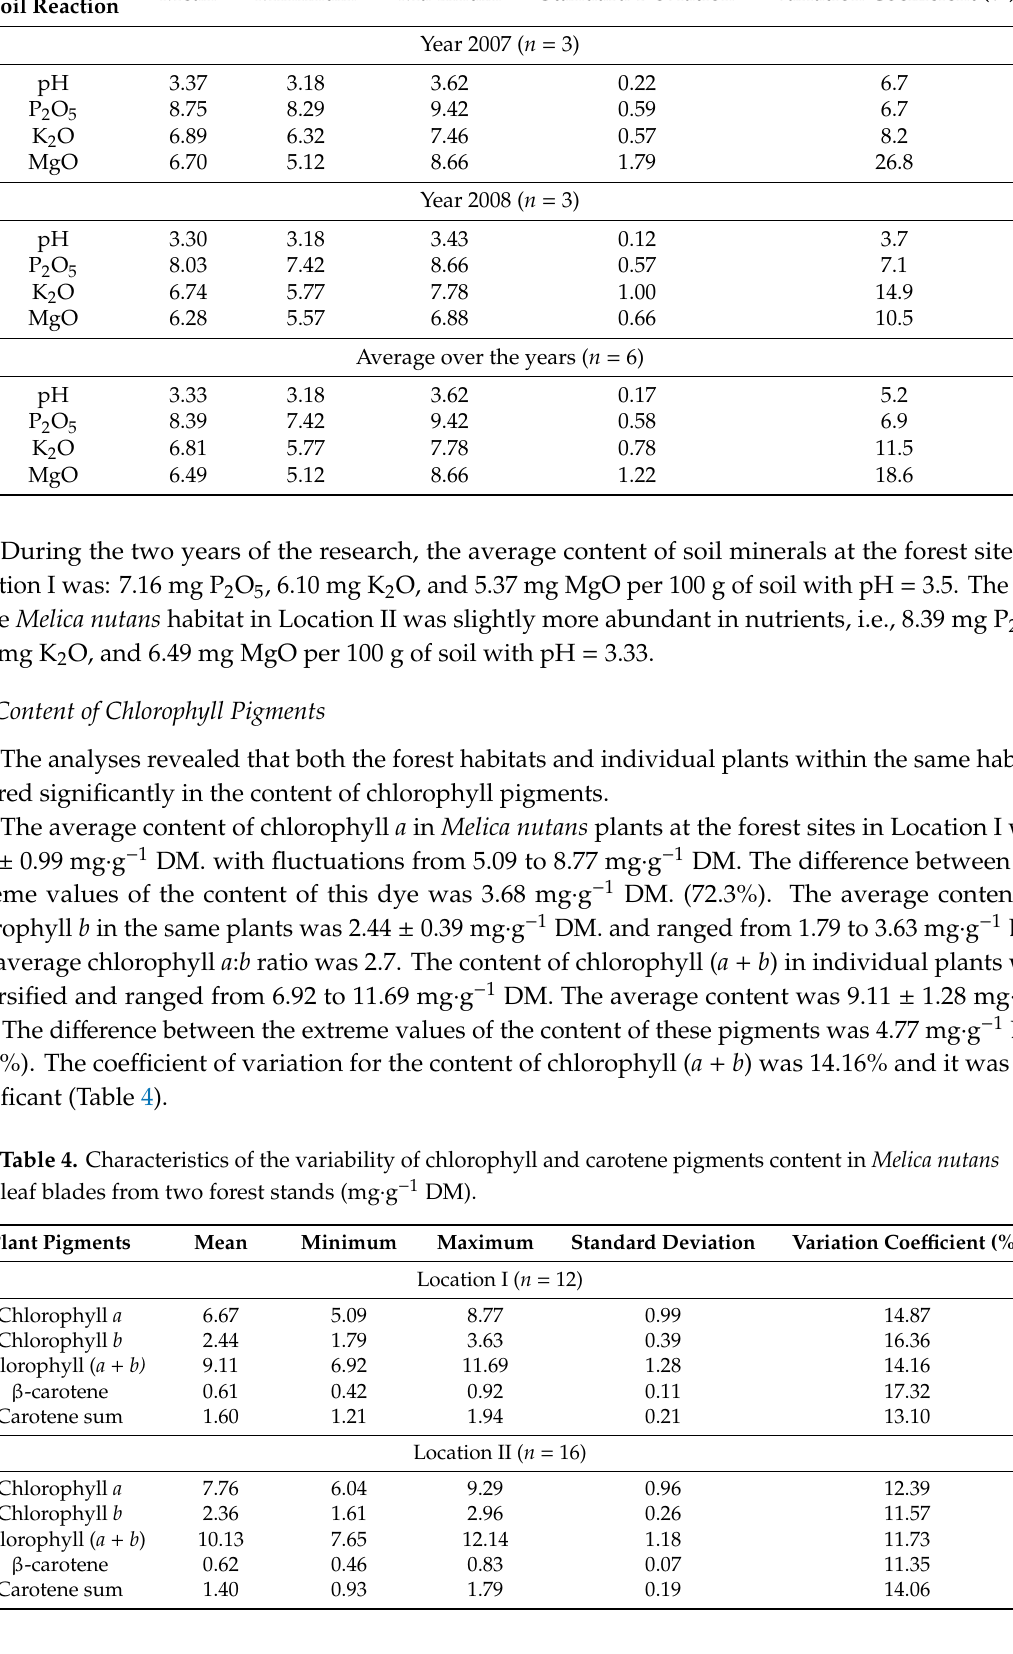
Table 3. Characteristics of soil conditions of a forest habitat located in Location II (mg · 100 g − 1 soil). Minerals and